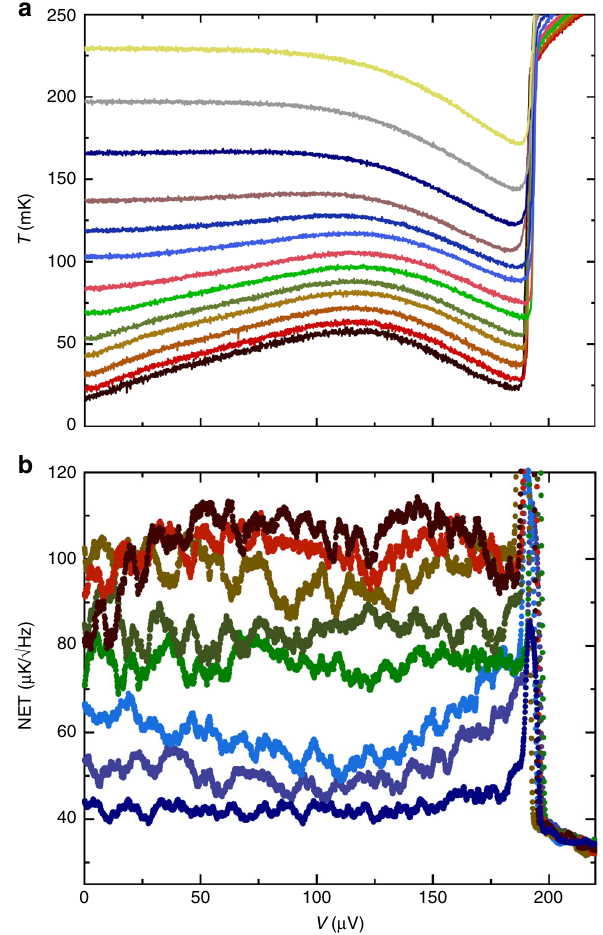
Fig. 4 Temperature and its fl uctuations under nonequilibrium conditions. a Average temperature of the absorber when the injecting junction is biased at different voltages V . The data sets correspond to bath temperatures 12, 27, 35, 43, 52, 67, 83, 100, 117, 135, 166, 198, and 233 mK from bottom to top. b Nonequilibrium temperature fl uctuations at temperatures 12, 27, 35, 52, 67, 100, 117, 166 mK with the same colors as in a as a function of injector